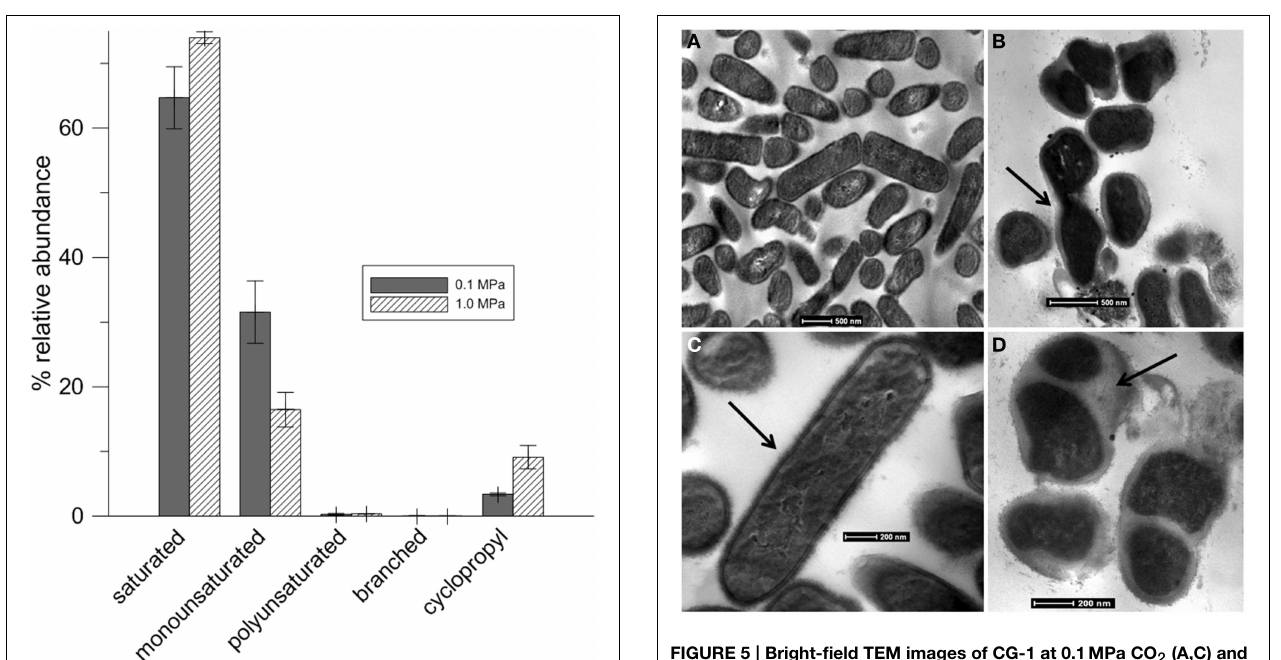
FIGURE 5 | Bright-field TEM images of CG-1 at 0.1MPa CO 2 (A,C) and 1.0MPa CO 2 (B,D). Arrows in: (B) show invaginations in CO 2 exposed cells that may suggest cell division; (C) show the intact cell wall for organisms at low CO 2 exposure; (D) show the capsular material present for CO 2 exposed